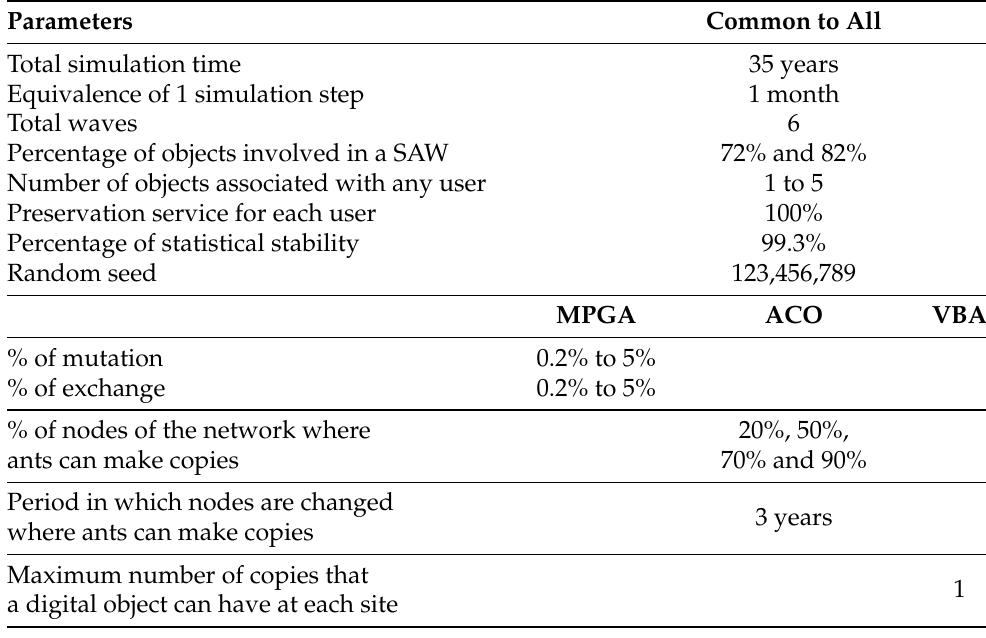
Table 2. Definition of the initial parameters used in the TiM simulations for every CI